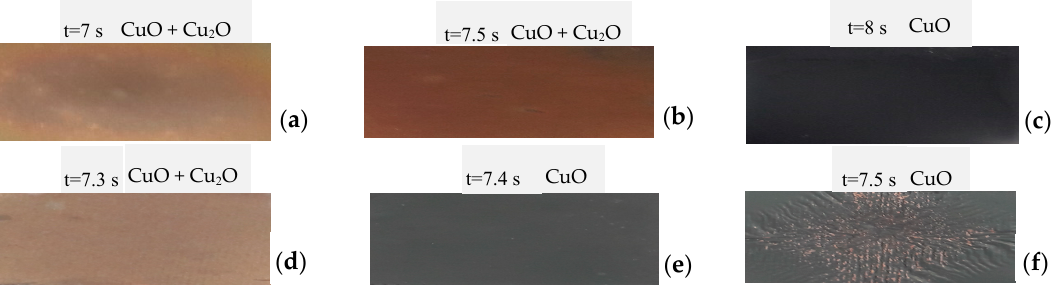
Figure 2. Chosen view of experimental samples after L1-2 ( a – c ) and L2-2 ( d – f ) process (where ( f ) presents an image of the sample immediately before remelting).